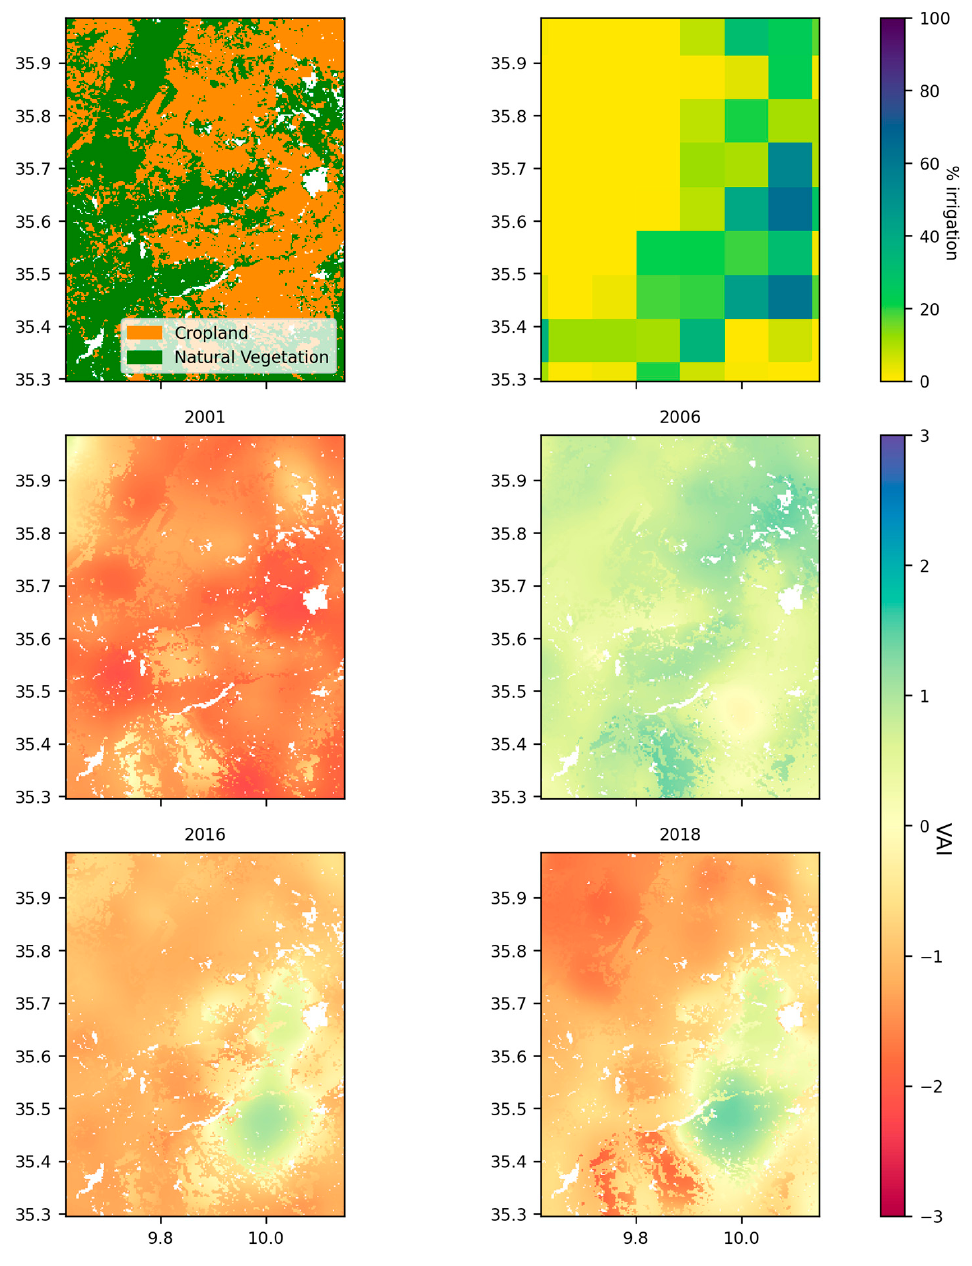
Figure 7. Maps of land use, irrigation, and VAI maps for March 2001, March 2006, March 2016, and March 2018, over the Kairouan site .